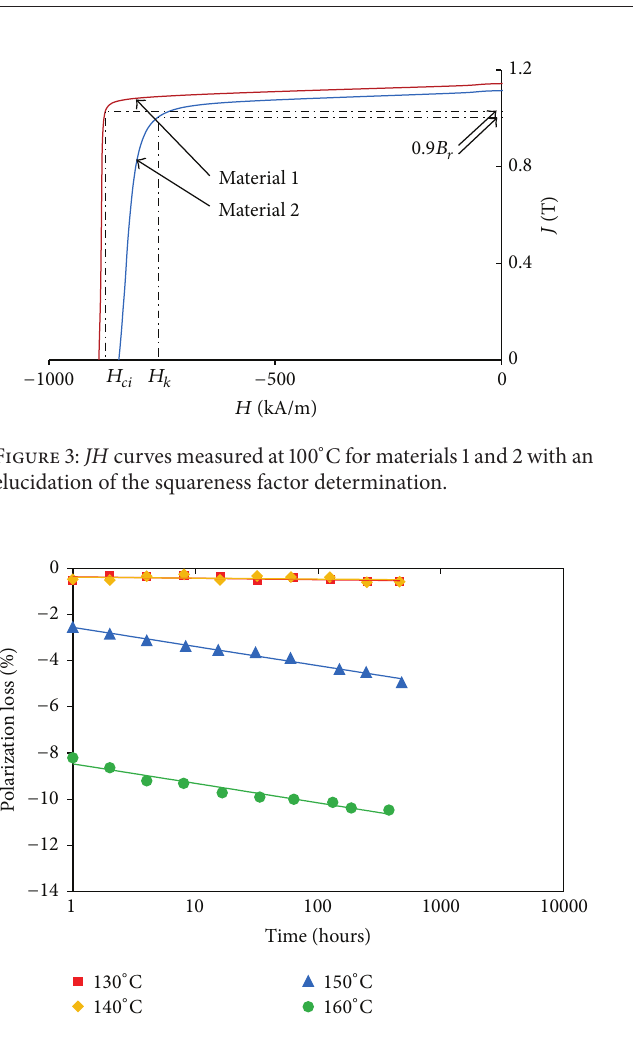
Figure 4: Polarization losses as a function of time at different temperatures in material 1 magnets.